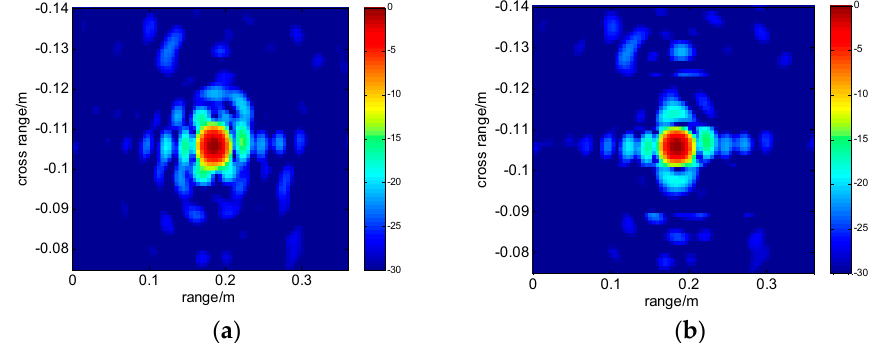
Figure 12. 2D imaging result of the ball in experiments, ( a ) is the imaging result before calibration and ( b ) is the imaging result after calibration.